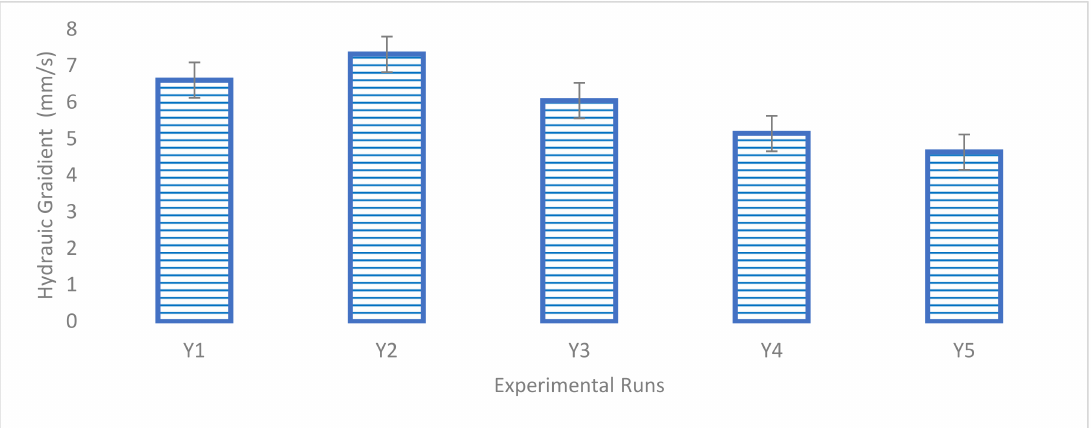
Figure 8. Hydraulic conductivity results.